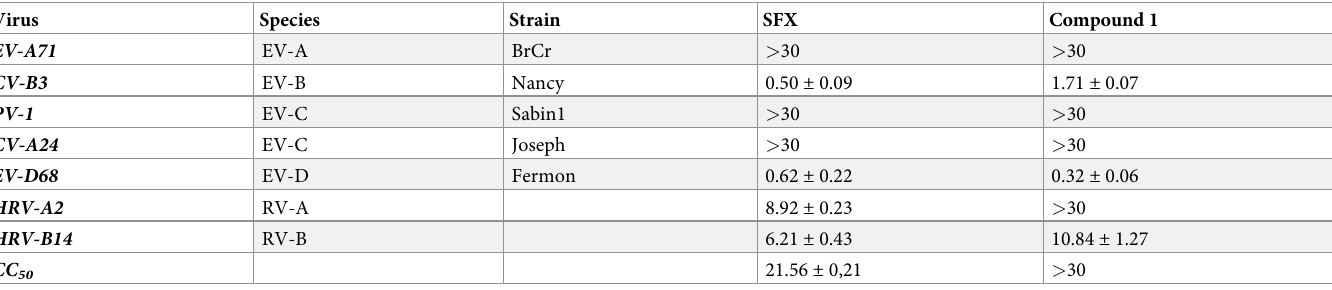
Multicycle viral replication assays were performed in HeLa R19 cells, and shown are EC 50 and CC 50 values in micromolar. Data represent mean ± SD calculated from at least three different experiments performed in biological triplicates. All underlying experimental data are displayed in S1